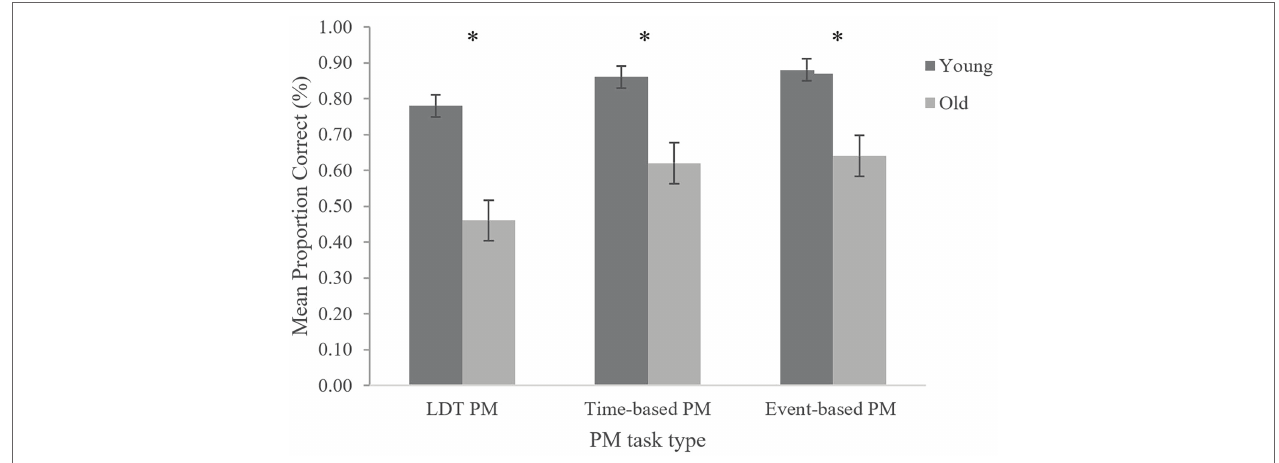
FIGURE 1 | Correct PM performance in all PM tasks for both age groups. Error bars represent the SE. * statistically significant, p <